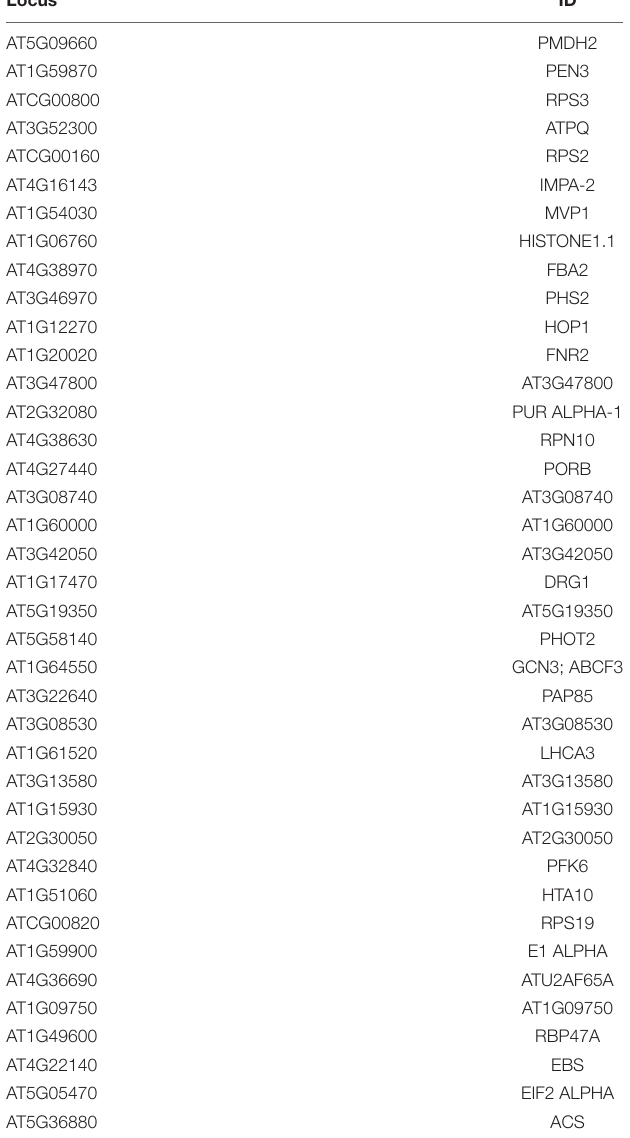
TABLE 2 | Proteins not identified in pulldown with scrambled probes in Col-0.